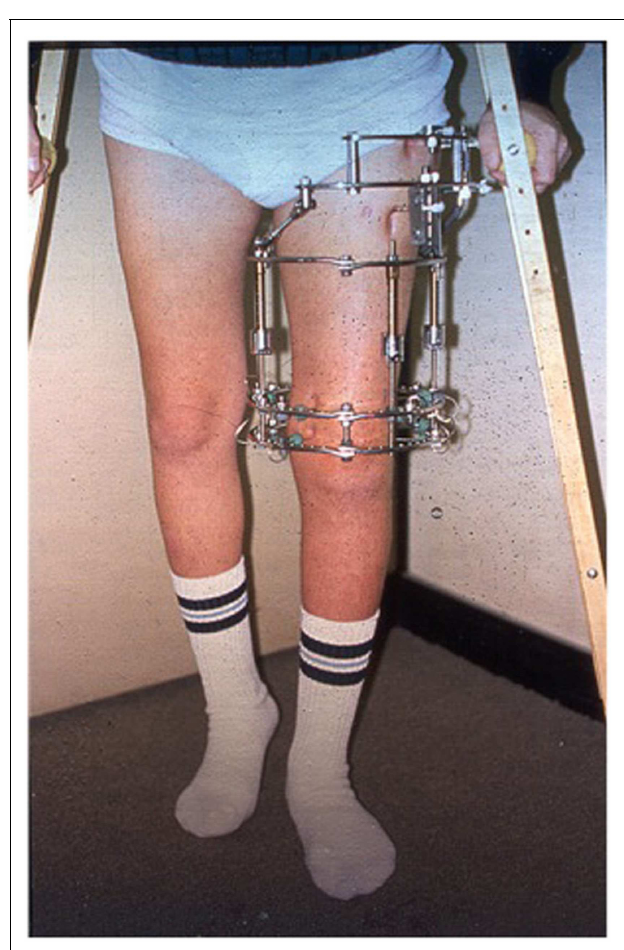
FIGURE 4 | Ilizarov ring fixator frame applied for distraction osteogenensis of the femur